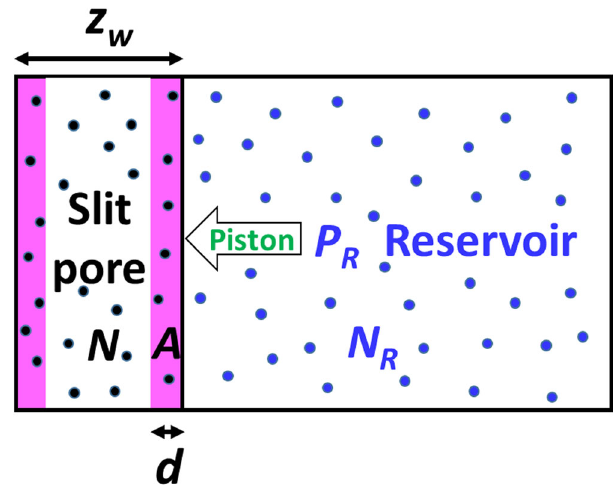
Fig.1| Schematicpresentationoftheconsideredsystem. N fl uidparticles(black dots) are con fi ned in a slit pore connected to a pressure reservoir of N R particles (blue dots) of the same fl uid with a pressure of P R , both at the same temperature. The porewall of surface area, A , on the right can slidefrictionlessly and servesasa piston also, thus the pore width z w (distance between the two pore walls) fl uc- tuates. The fl uid particles in the pink zones interact with the pore walls through a square-well potential of a range d